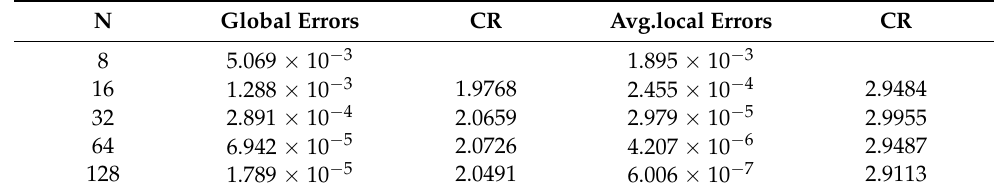
Table 1. Errors and convergence rate of Scheme 1 with the parameters of f ( 1 ) = 1.9, g ( 1 ) = 0.04,